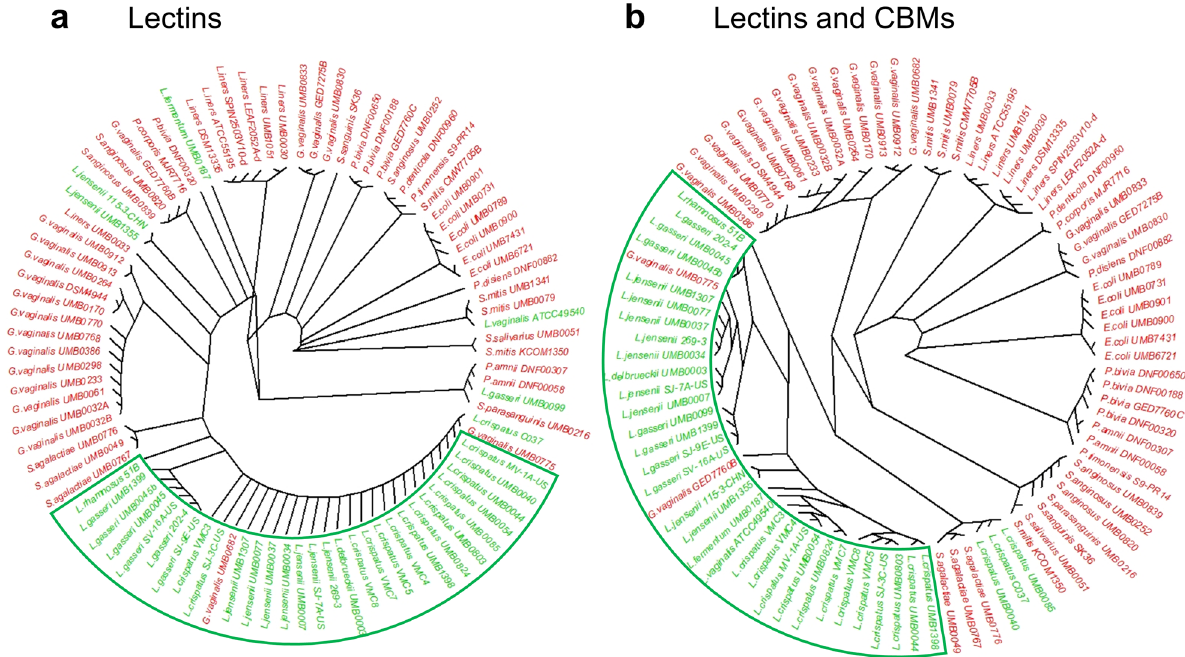
Fig. 5 Hierarchical radial tree of predicted classes of carbohydrate-binding proteins in vaginal bacteria. ( a ) Predicted lectin classes only or ( b ) lectin classes and predicted carbohydrate-binding modules in vaginal commensal (green), and con fi rmed and potentially pathogenic (red) bacteria. The ubiquitous LysM and CBM50 are excluded from the dataset to generate the hierarchical radial tree. Although the majority of Lactobacillus species clustered closely to each other, indicating similar putative lectomes, the lectome of L. iners isolates more closely resembled that of con fi rmed and potential